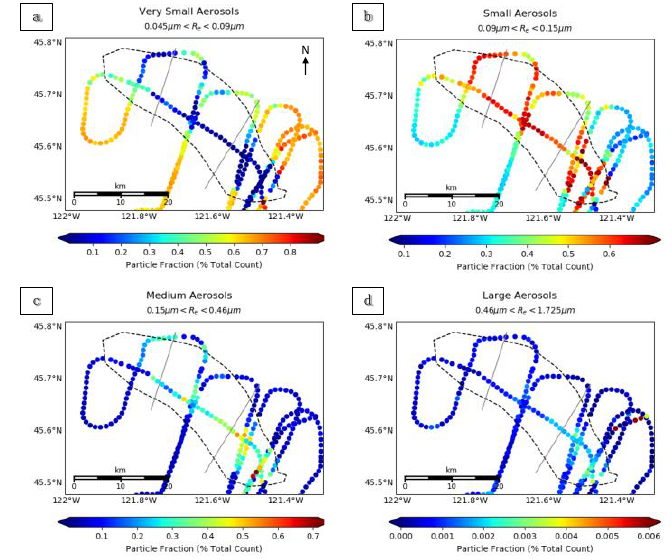
Figure 3. Fractional contributions (from zero to one) to the total aerosol count for (a) very small, (b) small, (c) medium, and ( d ) large aerosols in the Government Flats Complex Fire, as measured by the PCASP and CAS in situ instruments on 21 August 2013. The gray lines represent the boundaries between regions defined in Figure 1. Note: approximate size ranges are given above each plot, and the scales differ between categories. Table 4. Aircraft data: aerosol size, chemical, and physical properties for the Government Flats Complex Fire measured in situ .